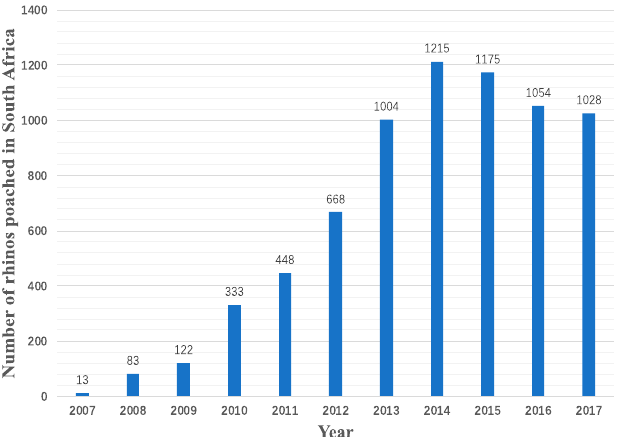
Figure 1. The number of rhinos poached in South Africa (2007–2017).